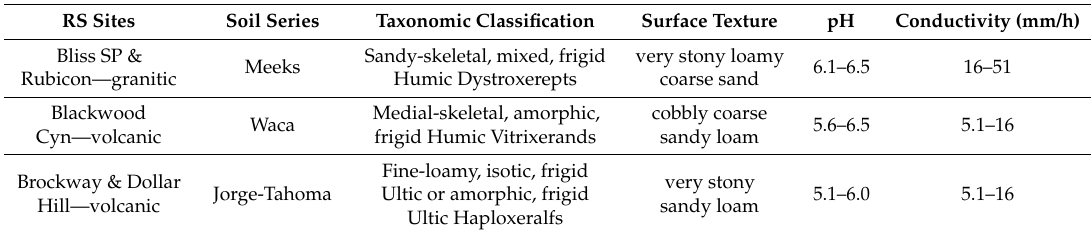
Table 1. Typical Tahoe soils encountered in the field measurements [53].